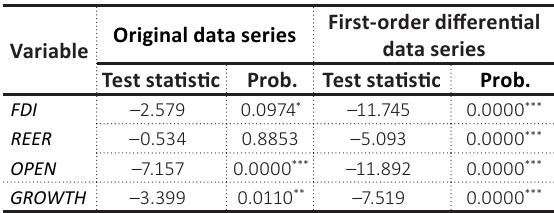
Source: Authors’ analysis results.